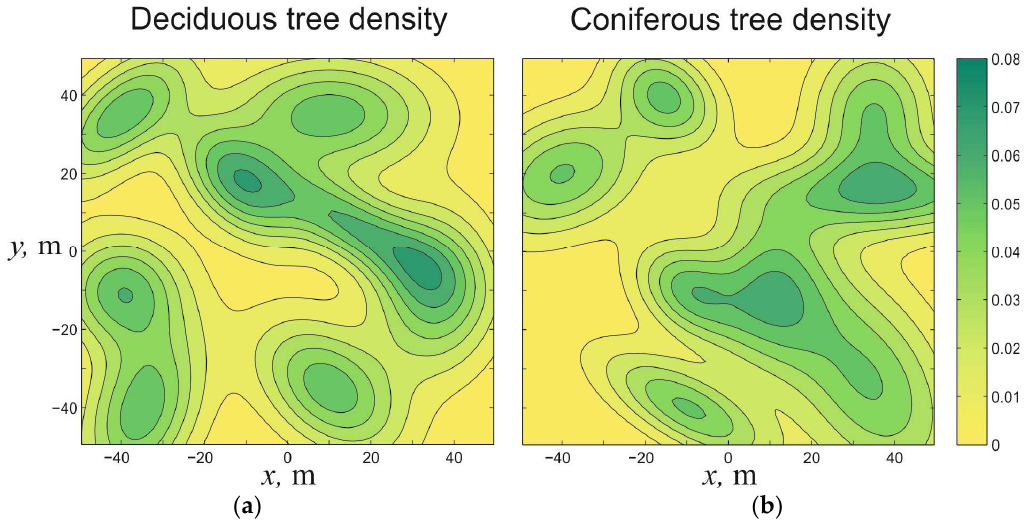
Figure 5. The modeling domain D for which the model functions ρ 1 ( x , y ) and ρ 2 ( x , y ) were reconstructed. It was assumed that deciduous and coniferous tree species were uniformly distributed within the modeling domain. Dashes indicate the grid cells for which the ratio of different tree species was retrieved.